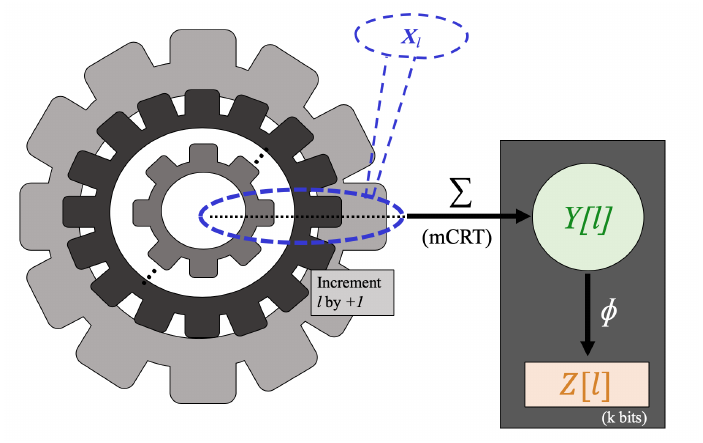
Figure 1. A visualization of the RNS PRNG computations. Table 1. Descriptions of the mathematical computations in Figure